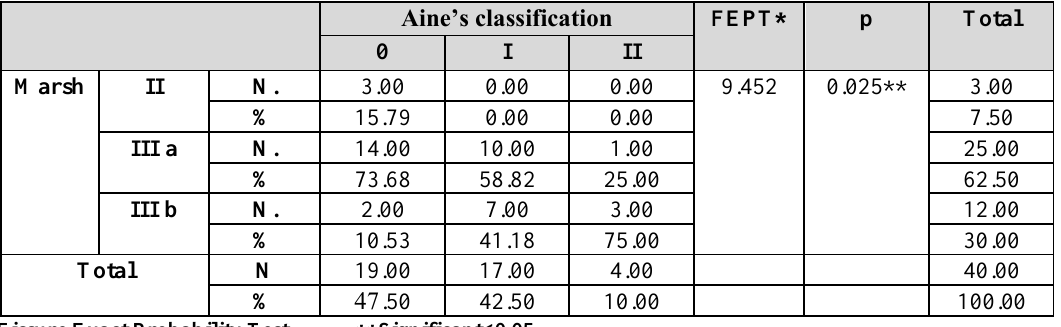
Table 2: Celiac disease dental enamel defects according to Aine’s classification in relation to the histopathological disease activity measured by modified Marsh-Rostami classification.